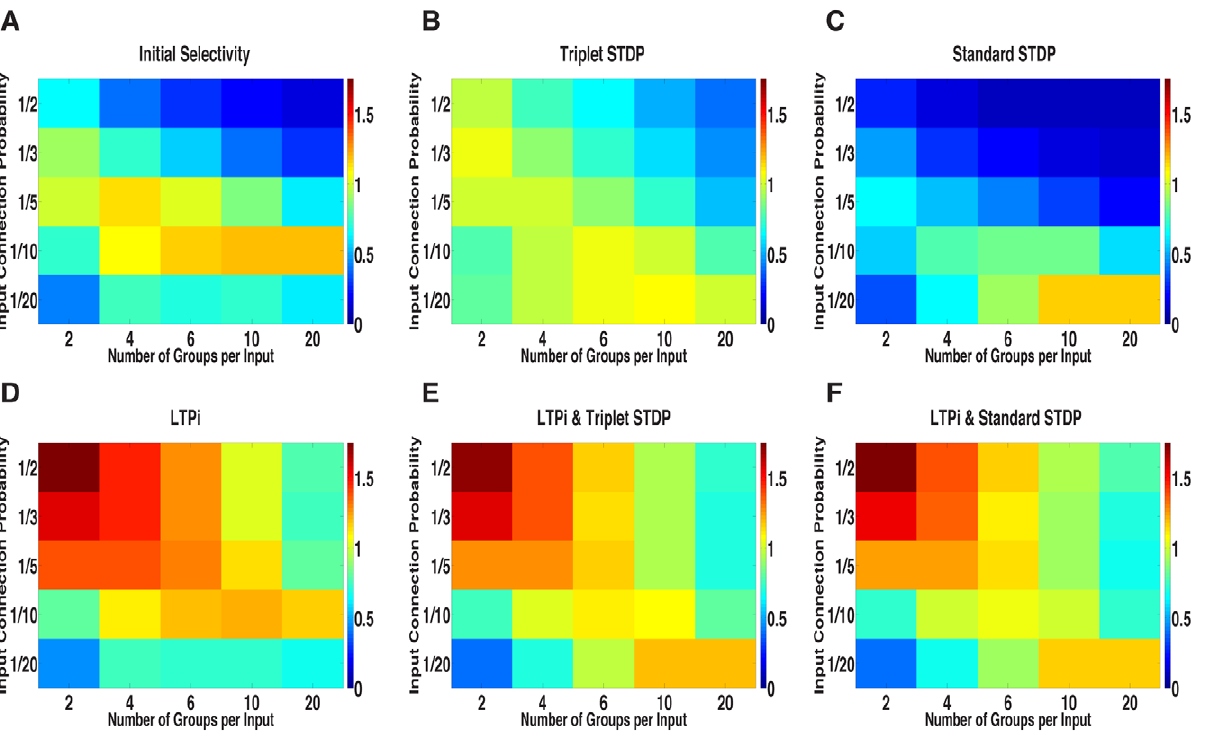
Figure 4. Network mean stimulus-pair selectivity. Each matrix contains the results for 25 networks, with 5 levels of input correlation (x-axis) and 5 levels of sparseness (y-axis) in one of six conditions: A . Before learning. B–F . following 800 trials with plasticity. B . after triplet STDP. C . after standard STDP. D . after LTPi alone. E . after triplet STDP + LTPi. F . after standard STDP + LTPi.